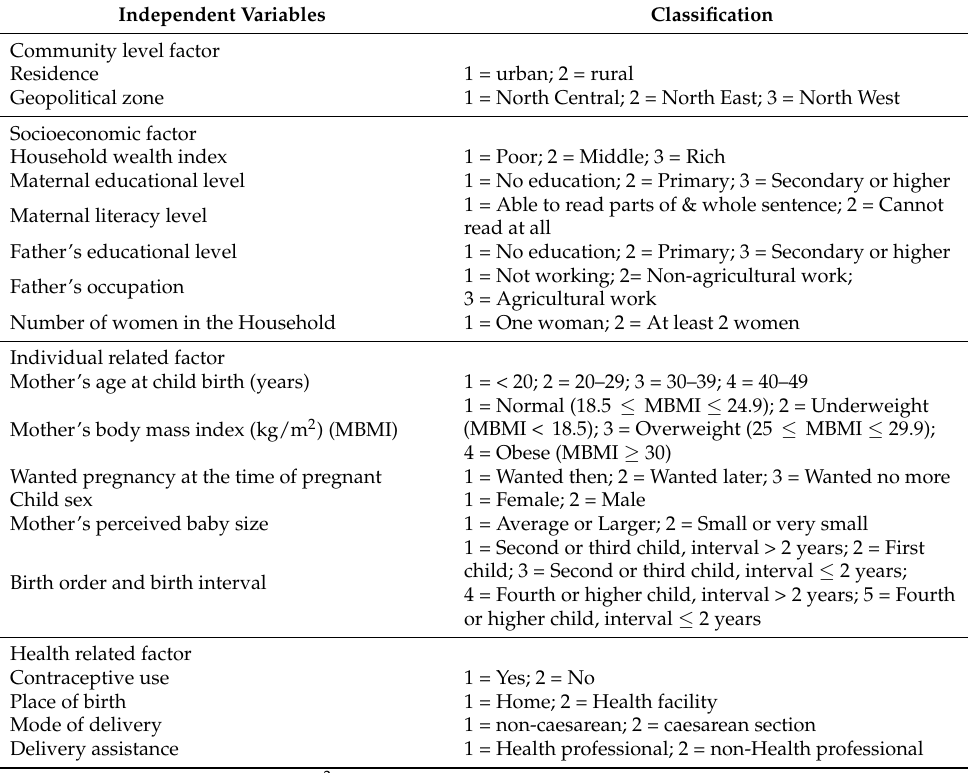
Table 1. Definition and classification of independent variables used for the study